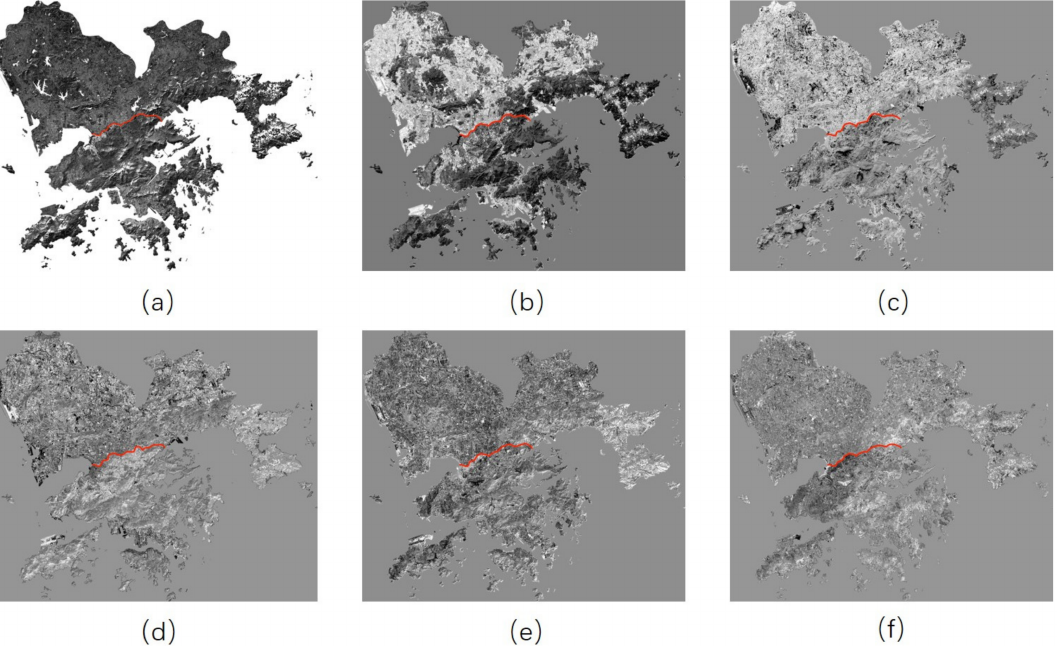
Figure 3. MNF components: ( a ) MNF Component 1; ( b ) MNF Component 2; ( c ) MNF Component 3;